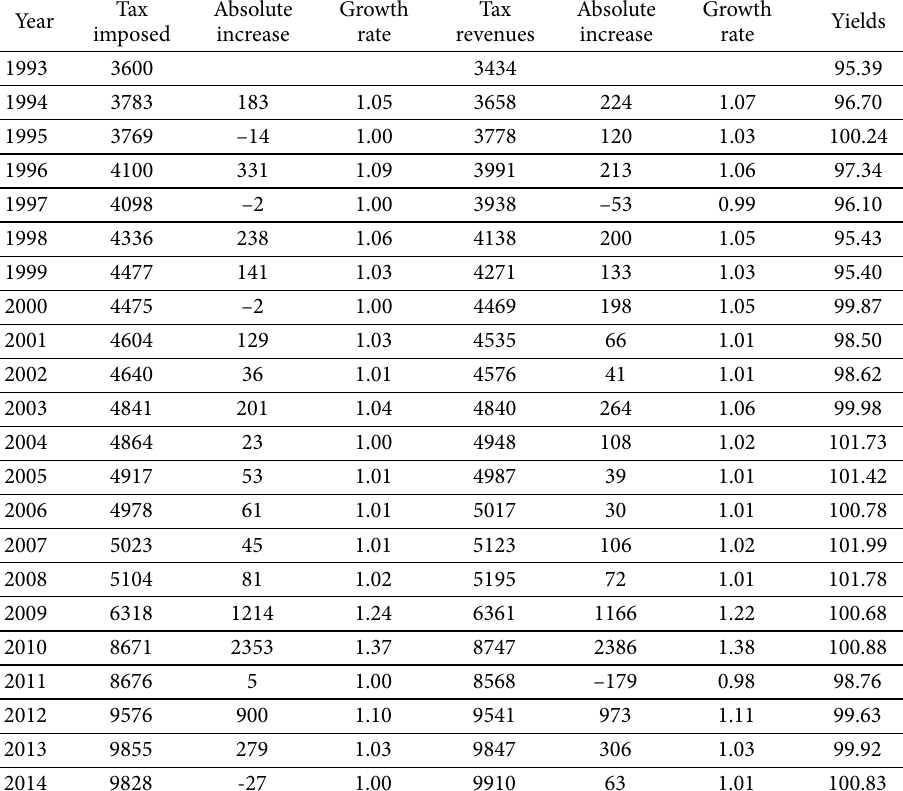
Table 1. Development of regulations and immovable property tax collections in the Czech Republic from 1993 to